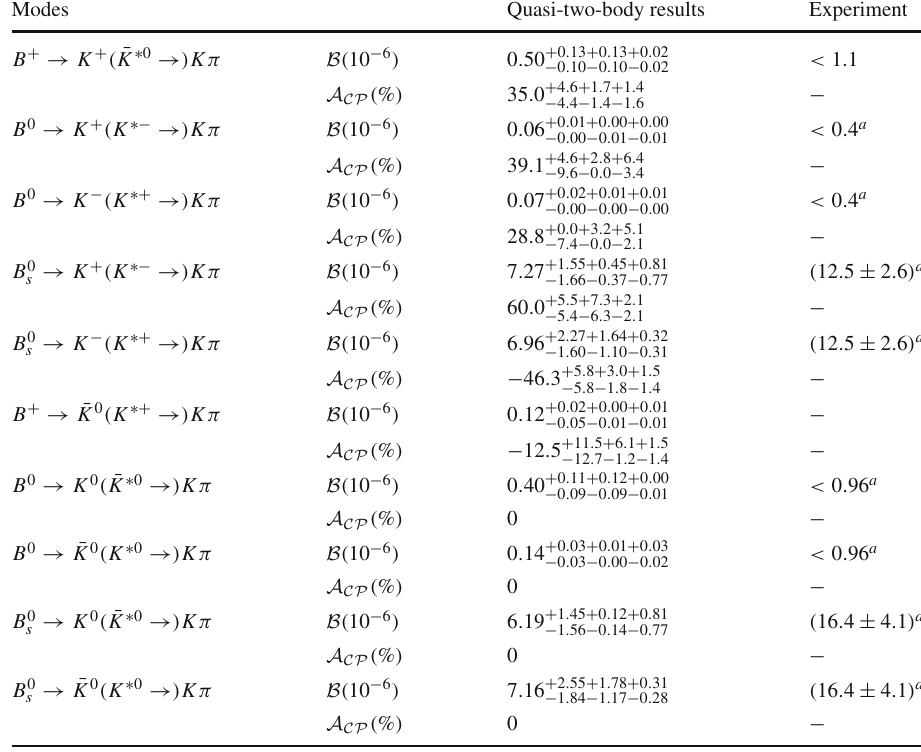
Table 2 The CP averaged Modes Quasi-two-body results branching ratios and direct CP -violating asymmetries of B ( s ) → π( K ∗ → ) K π decays calculated in PQCD approach together with experimental data [107,108]. The theoretical errors corresponding to the uncertainties due to the next-to-leading-order effects (the hard scale t and the QCD scale (cid:8) QCD ), the shape parameters ω B ( in the wave s ) function of B ( s ) meson and the || and Gegenbauer moments ( a 1 K ∗ || a ), respectively 2 K ∗